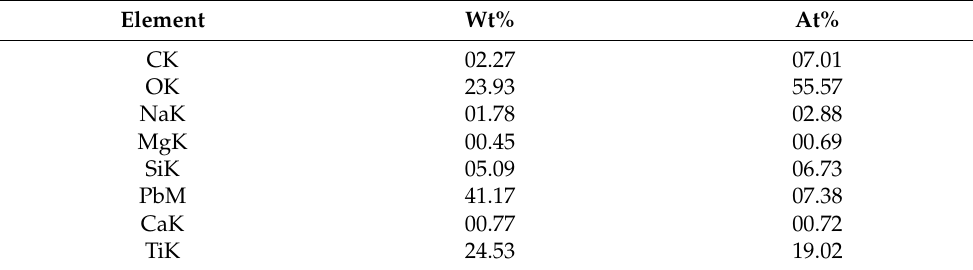
Table 3. The weight (%) and atomic (%) for each element in the sample with Pb:Ti of 1:2.